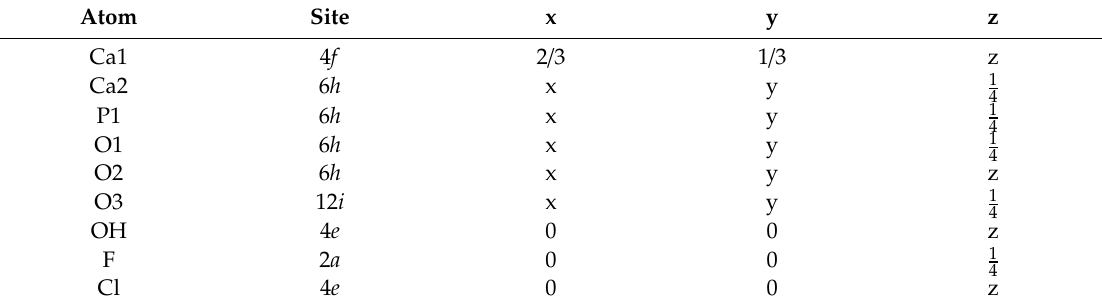
Table 4. Structural sites in Ca 10 (PO 4 ) 6 (OH, F, Cl) 2 apatite